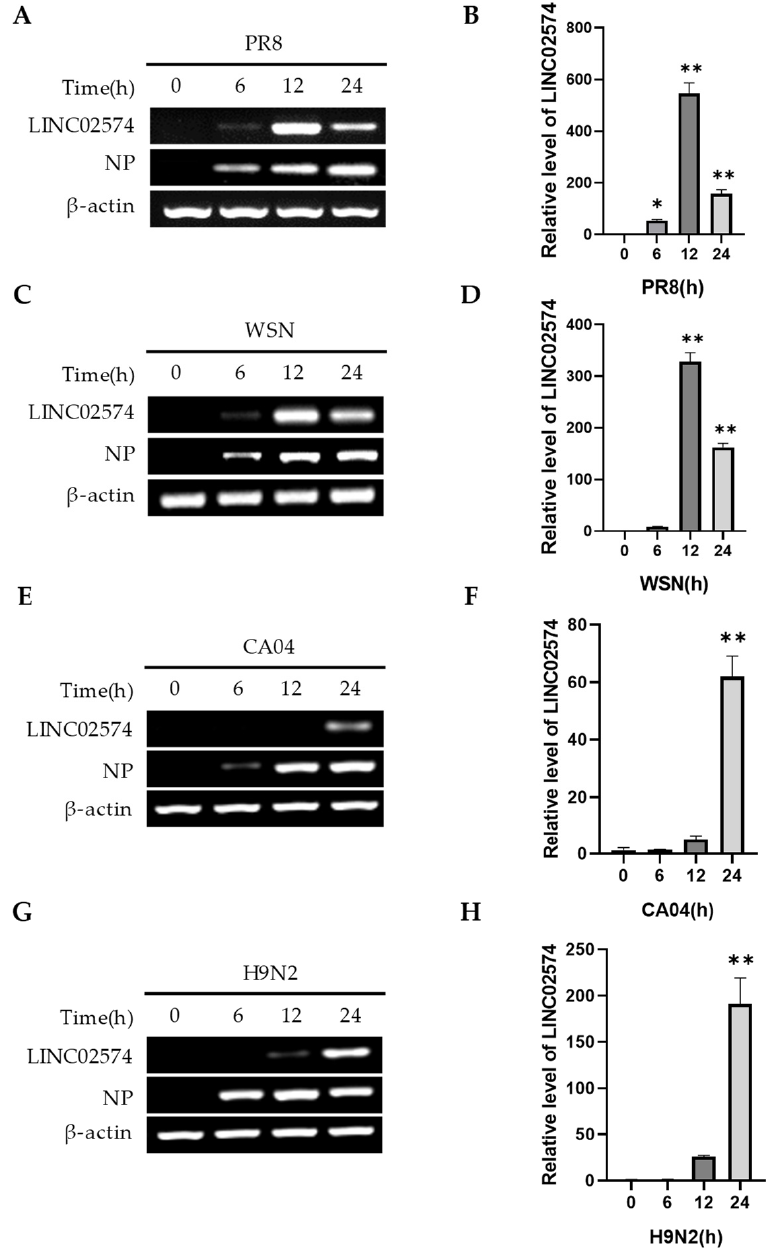
Figure 2. LINC02574 is induced by multiple virus infections. ( A – H ) The expression levels of LINC02574 in A549 cells infected with IAV PR8 ( A , B ), WSN ( C , D ), CA04 ( E , F ), and H9N2 ( G , H ) were examined by RT-PCR and qRT-PCR. Data are represented as mean ± SD; n = 3; One-way ANOVA followed by LSD test: * p < 0.05, ** p < 0.01 versus time 0 h.